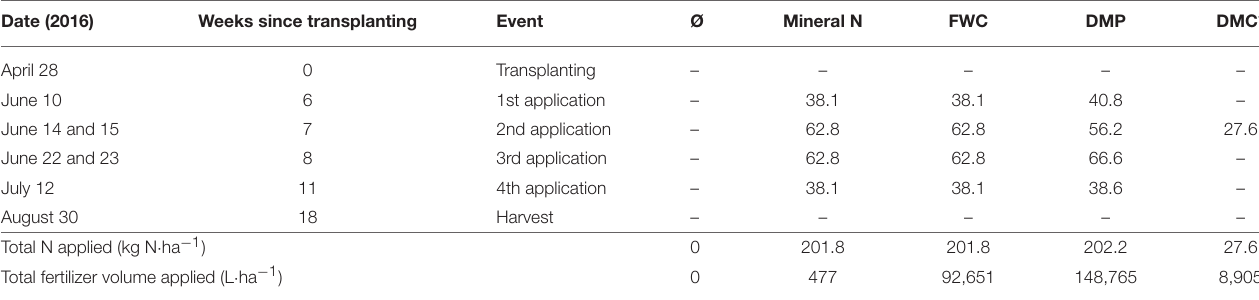
TABLE 1 | Fertilizer application schedule of mineral N fertilizer (UAN-32), ultrafiltered dairy manure digestate (DMP), concentrated dairy manure digestate (DMC), and concentrated food waste digestate (FWC); amount of N delivered (kg N · ha − 1 ); and volume of liquid fertilizers